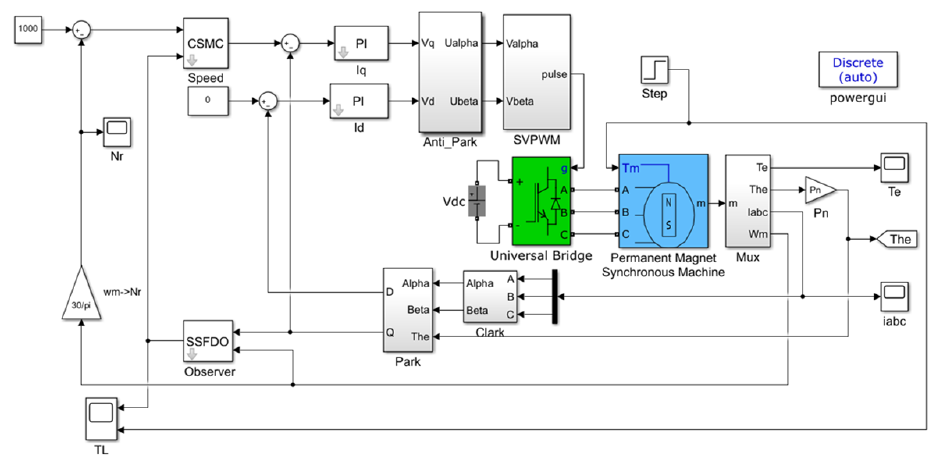
Figure 5. System simulation model.